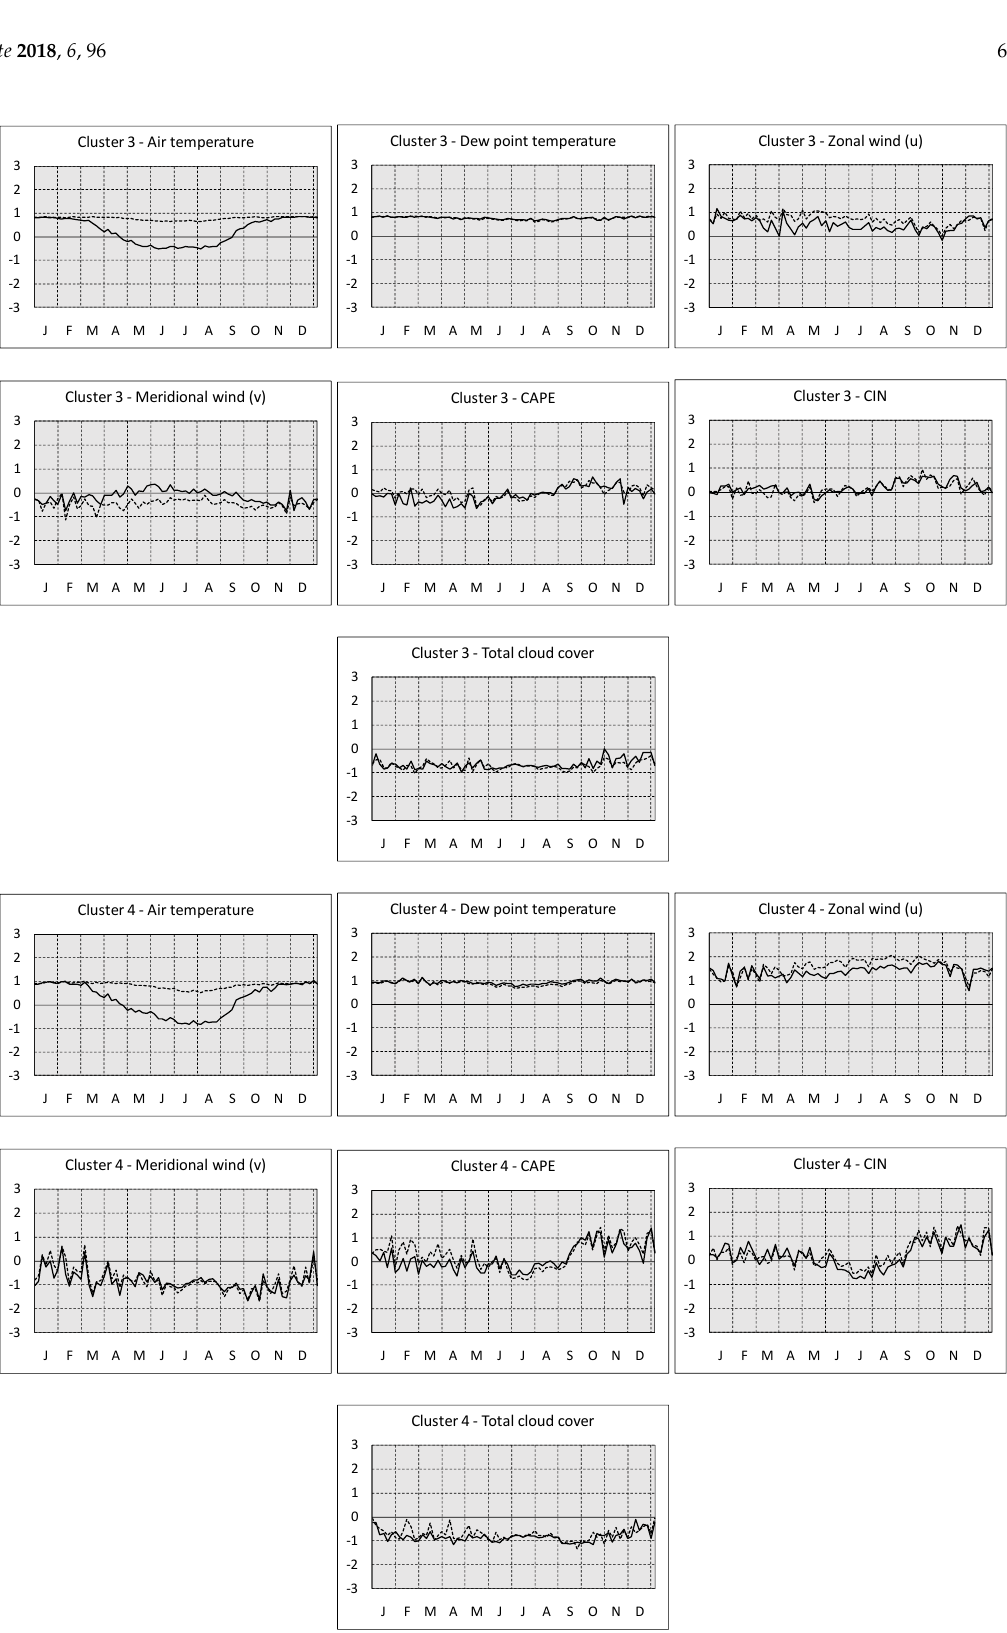
Figure 5. As in Figure 4, but for clusters 3 and 4.